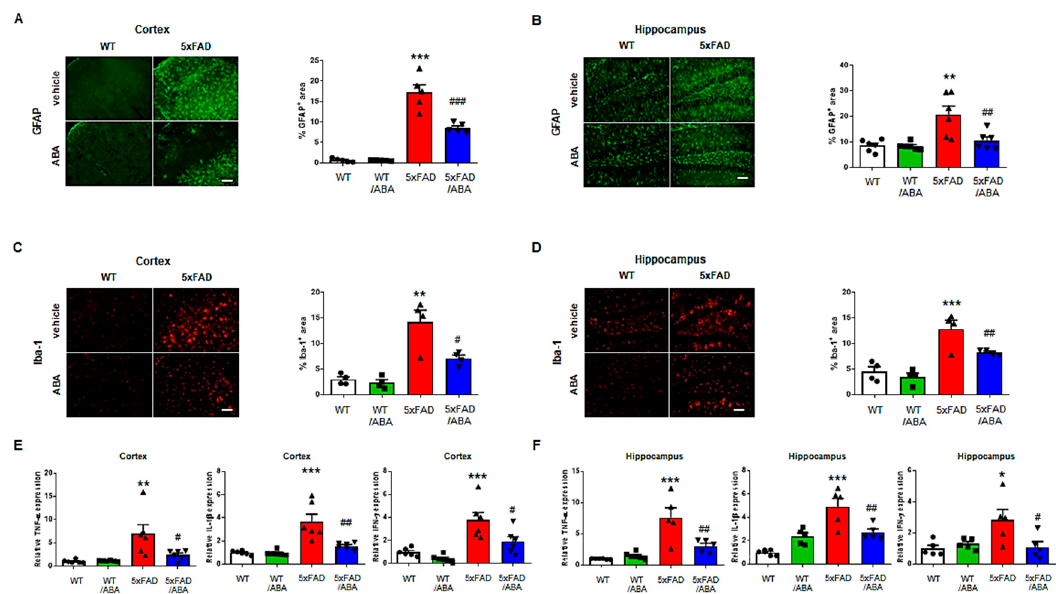
Figure 4. ABA ameliorates inflammation related factors in the 5xFAD mice brains. ( A , B ) Representative images of glial fibrillary acidic protein (GFAP) and the percentages of GFAP positive areas in the ( A ) cortex and ( B ) hippocampus quantified by using Image J software ( n = 5–6, scale bar = 50 µ m). ( C , D ) Representative images of ionized calcium-binding adaptor molecule 1(Iba-1) and the percentages of Iba-1 positive areas in the ( C ) cortex and ( D ) hippocampus quantified by using Image J ( n = 4, scale bar = 50 µ m). ( E , F ) The expression of tumor necrosis factor alpha (TNF- α ), interleukin-1 β (IL-1 β ), and interferon- γ (IFN- γ ) in the ( E ) cortex and ( F ) hippocampus ( n = 5–6). All data are expressed as the mean ± S.E.M. Statistics were analyzed by one-way ANOVA with Tukey’s post hoc test. * p <